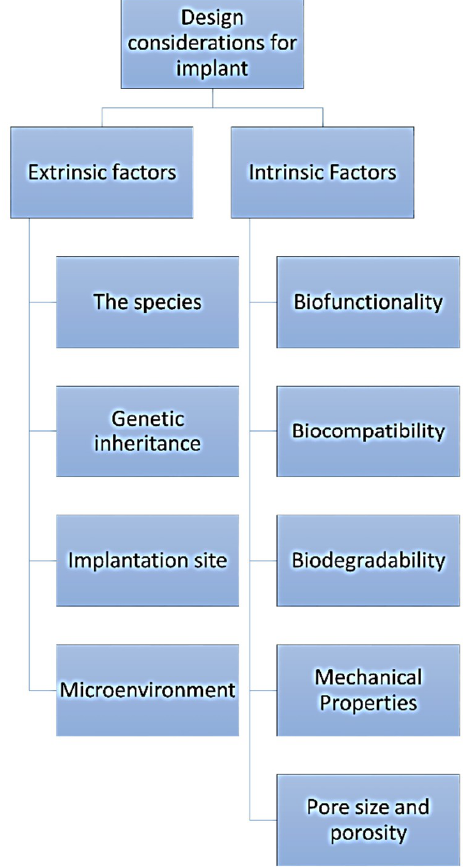
Figure 8. A general classification of several factors needs to be considered when designing an implant material.